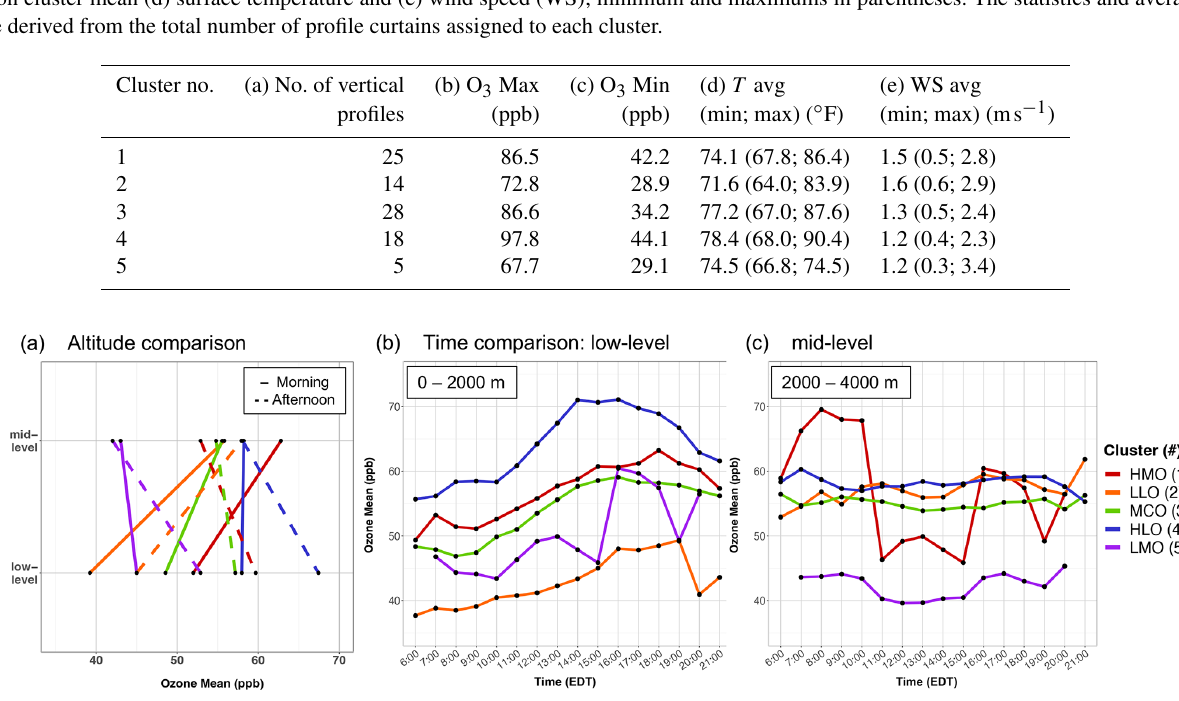
Figure 3. Lidar O 3 cluster average comparisons (five clusters depicted in colors). (a) Altitude comparison of mean O 3 averaged over time: morning hours from 6:00–12:00 (solid line) and afternoon hours from 12:00–21:00 (dashed lines). Time comparison of mean hourly O 3 split between the (b) low level and (c)